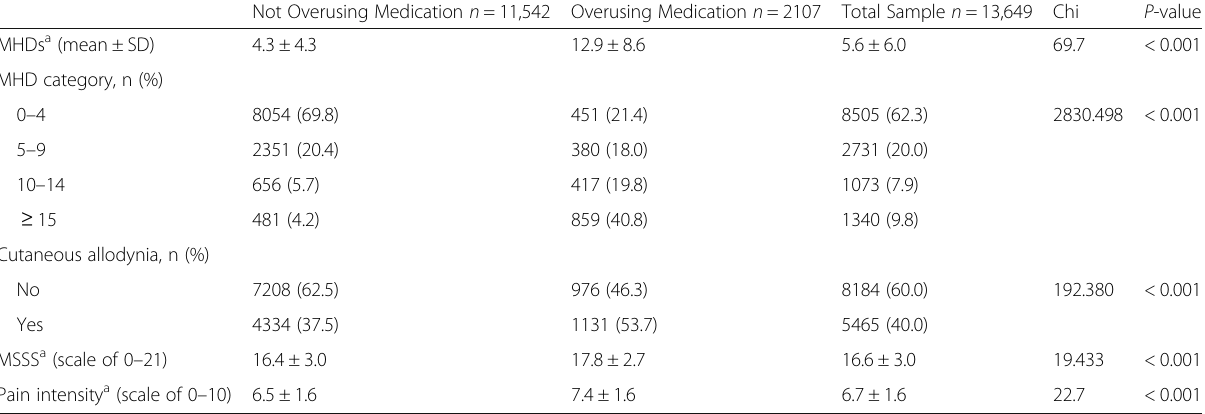
Table 2 Headache Features and Characteristics of Respondents with Migraine According to Medication